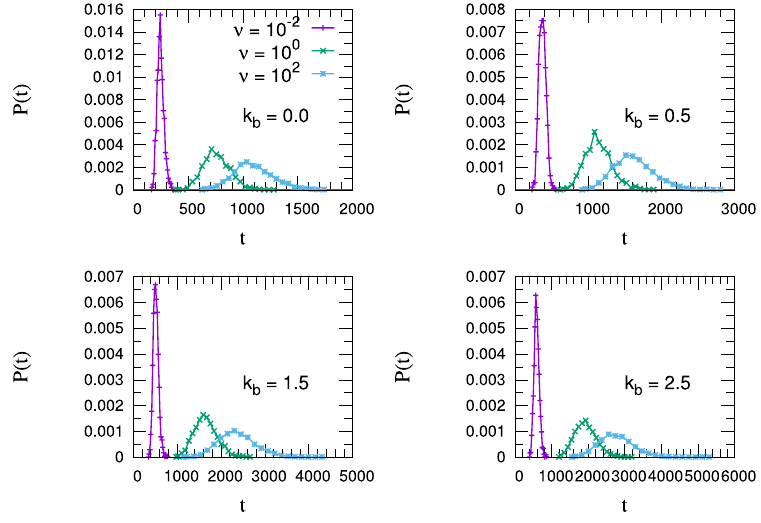
Figure 6. Translocation time distribution P ( t ) for k b = 0.0, 0.5, 1.5, 2.5 with N =